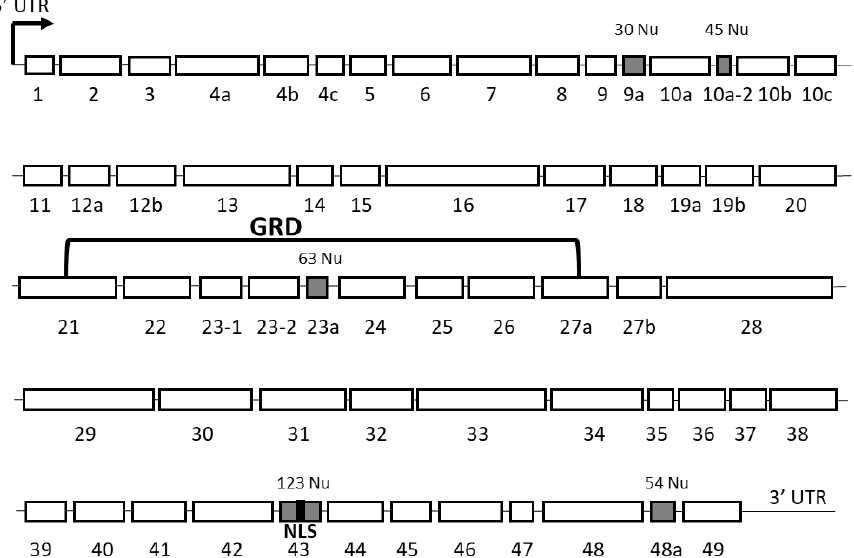
Figure 2. Schematic representation of the exons of the full-length transcript of NF1 according to the old nomenclature. The alternatively spliced exons are indicated in grey with their number of nucleotides. The nuclear localization signal (NLS) in exon 43 (in black) and the GAP-related domain (GRD) are indicated; Nu: